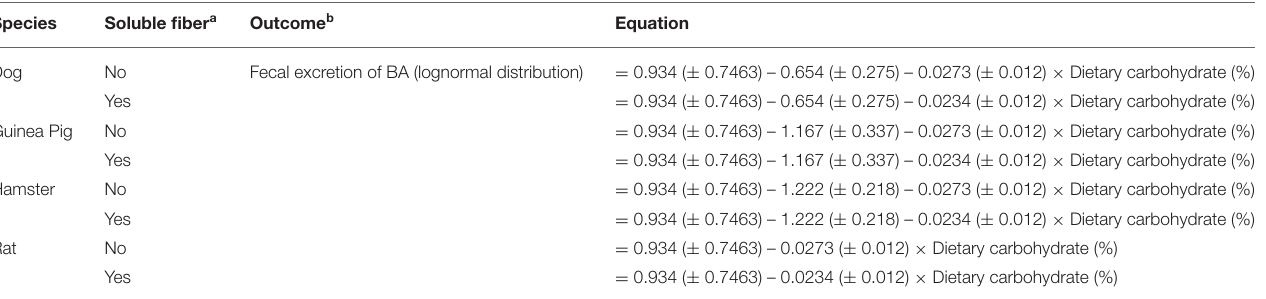
TABLE 6 | Carbohydrate model equations for total fecal bile acids excretion.